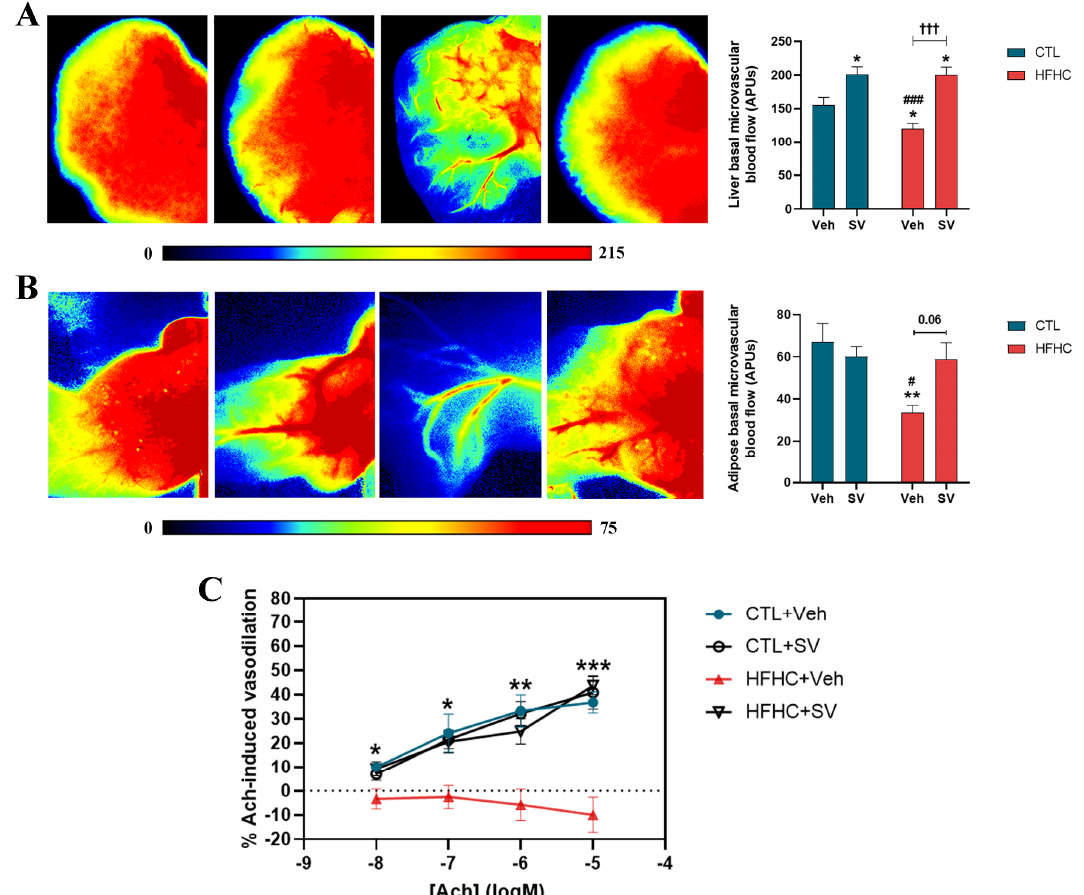
Figure 4. Effect of SV on hepatic and visceral adipose tissue microvascular perfusion. Liver and epididymal adipose tissue microvascular blood flow assessed by laser speckle contrast imaging (LSCI). Representative images of LSCI and microvascular blood flow quantification in the left lateral hepatic lobe (LLL) ( A ) or epididymal fat deposit ( B ) in mice fed with control diet (CTL+Veh), control diet plus SV (CTL+SV), HFHC diet (HFHC+Veh), or HFHC diet plus SV treatment (HFHC+SV). The color scale represents blood flow in arbitrary perfusion units (APUs). Percentage of change in adipose tissue blood flow following topical administering of crescent doses of 2% acetylcholine (Ach) is demonstrated in ( C ). * p < 0.05 vs. CTL+Veh; ** p < 0.01 vs. CTL+Veh; *** p < 0.001 vs. CTL+Veh; # p < 0.05 CTL+SV; ### p < 0.001 vs. CTL+SV; ††† p < 0.001 vs. HFHC+SV.